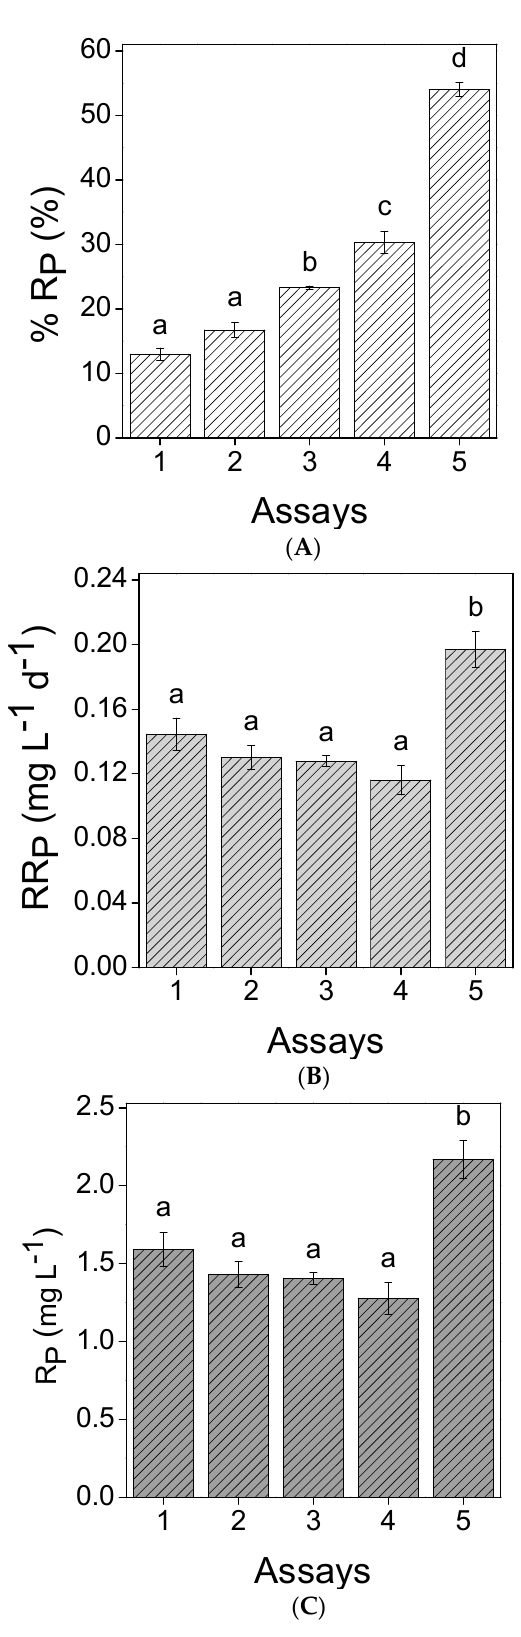
Figure 5. Phosphorus (phosphate) removal parameters obtained by C. vulgaris cultures grown in raw and diluted secondary-treated paper industry effluent (assays 1–5): ( A ) removal efficiency (%R P ); ( B ) average removal rate (RR P ); and ( C ) mass removal (R P ). Error bars correspond to the standard deviation of the mean obtained from two independent experiments. Mean values sharing at least one common letter (shown above the bars) are not statistically different ( p >0.05).